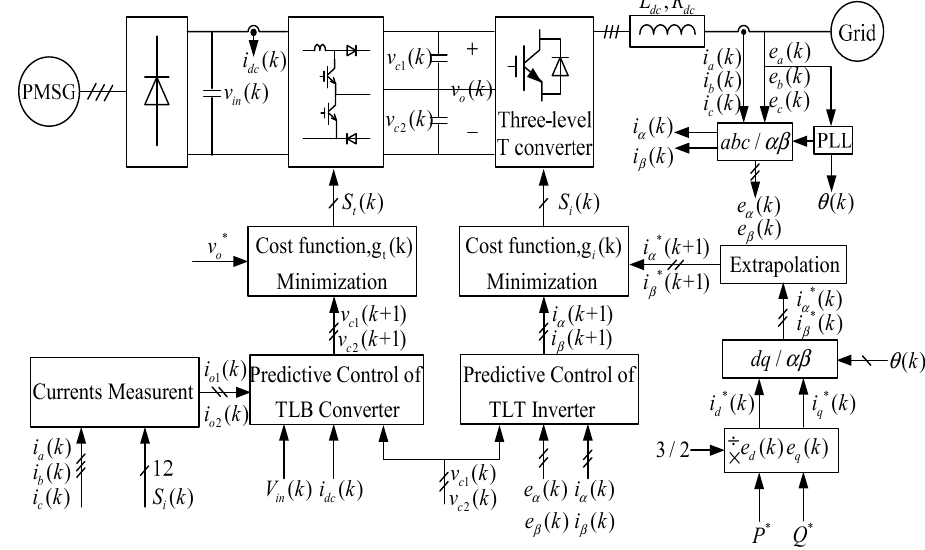
Figure 8. Predictive control scheme of the BTL and the three-level T-type inverter. Algorithms 2018 , 11 , x FOR PEER REVIEW